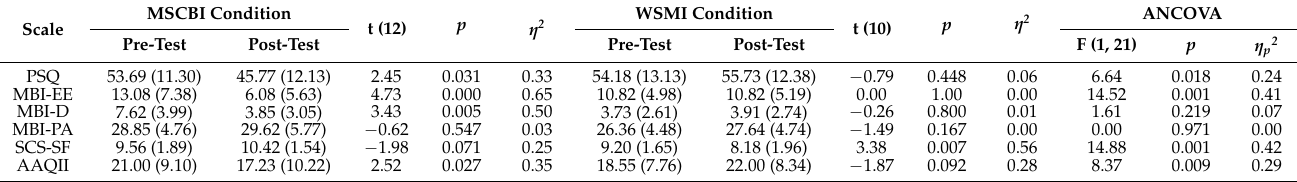
Table 3. Means, standard deviations, paired samples t-test, and ANCOVA comparing primary and secondary outcomes.